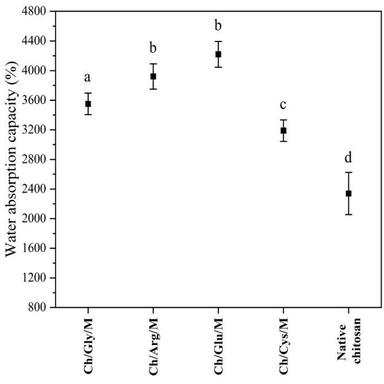
Swelling of methylated chitosan derivatives. Points with different letters mean significant statistical differences (p ≤ 0.05), according to Tukey's post hoc test.